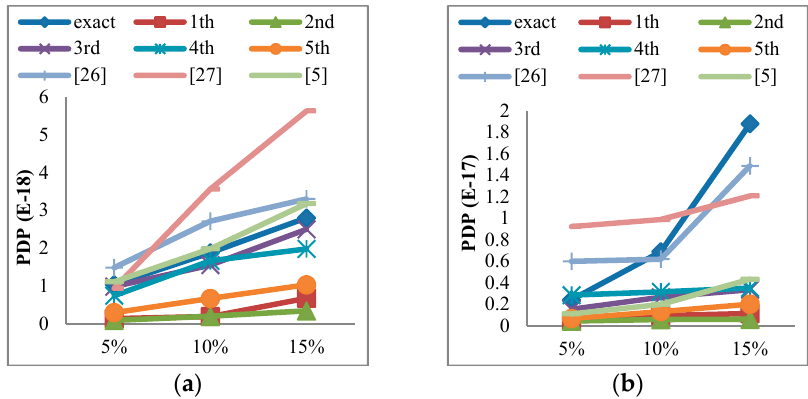
Figure 9. Operation of the proposed methods under supply voltage variations.